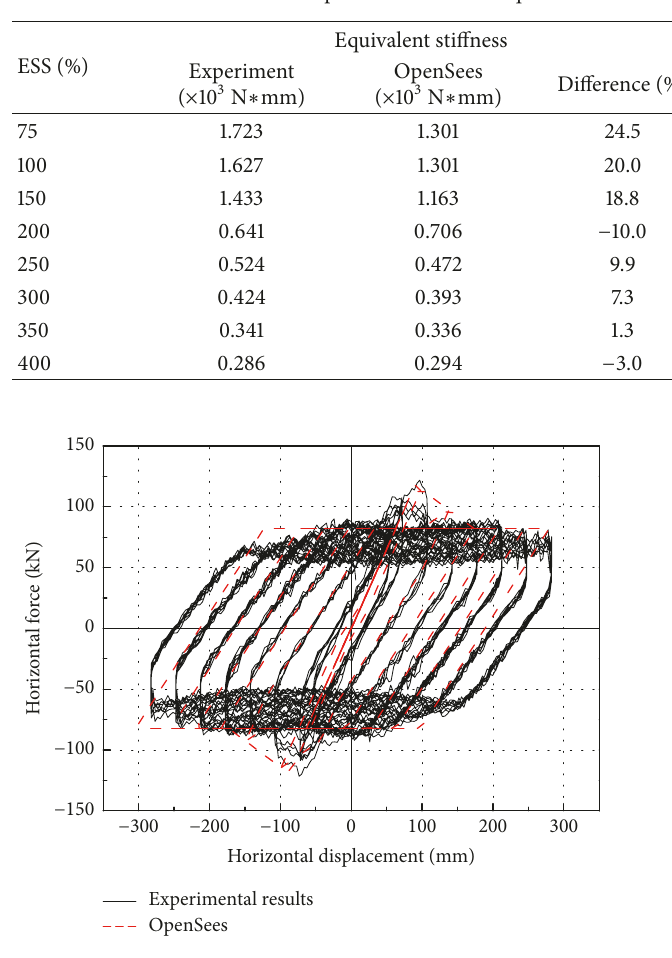
Figure 12: Comparison between experimental results and analytical results of specimen Y2-8/45-UB.